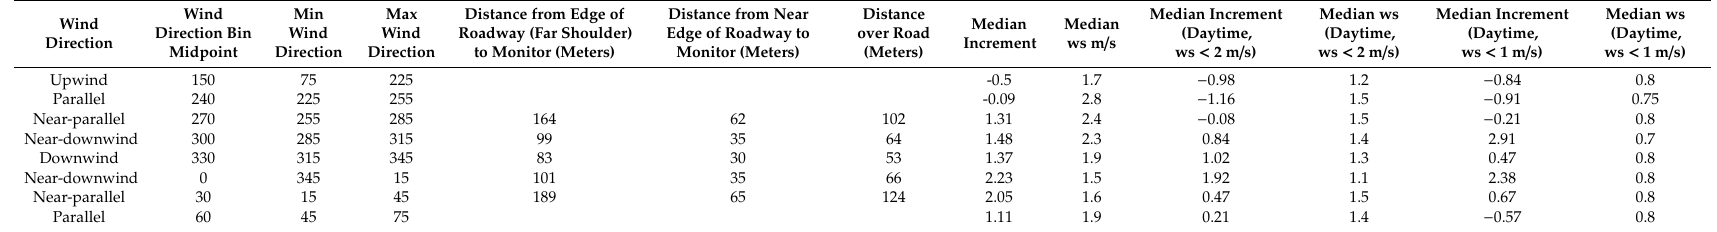
Table 2. For Indianapolis near-road site, distances to and over roadway, median increment (all hours, 06:00–20:00 [“daytime”] with wind speed less than 2 m / s, and daytime hours with wind speed less than 1 m / s), and median wind speeds (ws) by wind direction bins. Wind